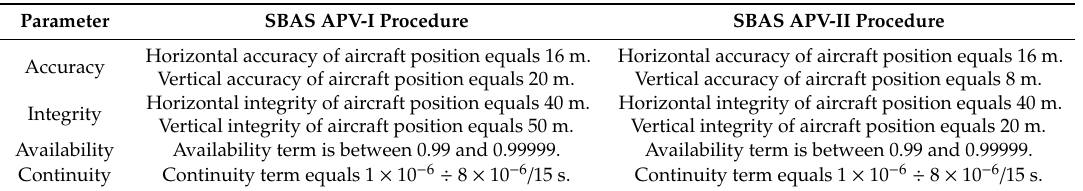
Table 1. Requirements of SBAS APV-I (Satellite Based Augmentation System Approach with Vertical Guidance-I) and SBAS APV-II approach to landing procedure in Polish aviation [3].